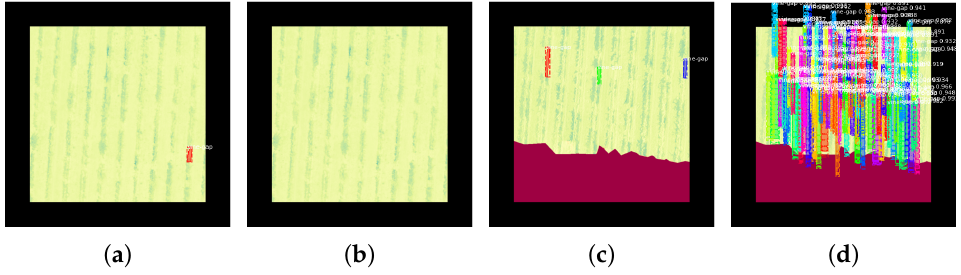
Figure 7. Examples of Mask-RCNN, after training ‘head’ layers for 30 epochs. Dataset: NDRE; Weights ( a , b ) YOLO; ( c , d ) Tiny-YOLOv2; ( a , c ): Original; ( b , d ): Detected. The Detected images ( b , d ) show two different network outputs in the same dataset and network. The image in ( b ) failed to detect the gap in ( a ), and the image in ( d ) predicted too many gaps in ( c ). At this point, the network seems to also be mostly incapable of detecting the gaps that are closer to 45º in orientation, as seen in Figure 8. This is due to the decreased amount of images, with crops being displayed diagonally in the dataset and the training time being only 30 epochs.